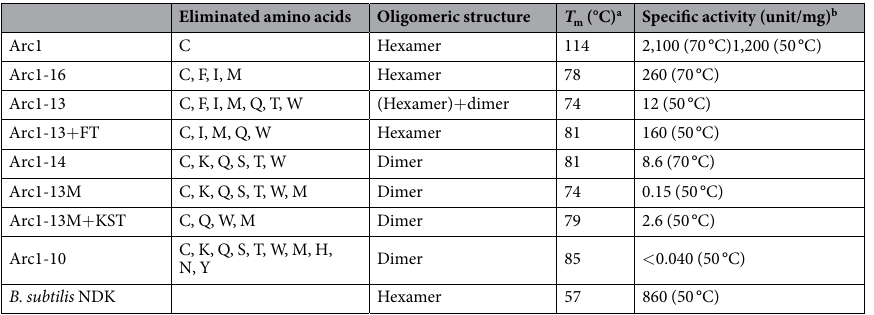
Table 1 and Supplementary Fig. S1) and its specific activity was also significant (260 units/mg at 70 °C; Table 1). We further eliminated three amino acid letters (Q, T, W) from Arc1-16, thus producing Arc1-13 (Fig. 2 and Supplementary Table S1). The thermal stability of Arc1-13 ( T m = 74 °C) was substantially lower than that of Arc1 ( T m = 114 °C) but still much higher than that of an extant mesophilic NDK from Bacillus subtilis ( T m = 57 °C; Table 1 and Supplementary Fig. S1). The specific activity of Arc1-13 was 12 units/mg at 50 °C (Table 1). Therefore,